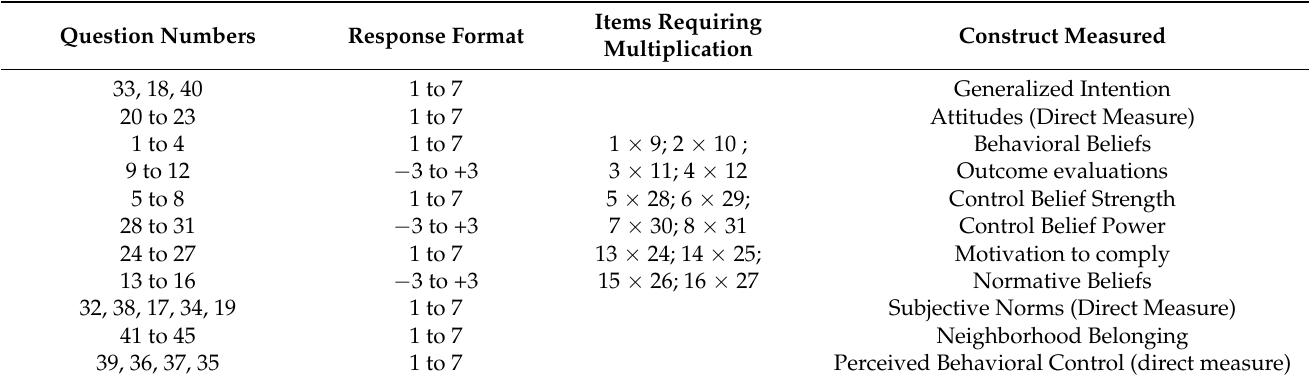
Table 7. Scoring Key for Energy-Saving Behavioral Questionnaire (the table was created by using the resource of Ajzen and Fishbein, 2005